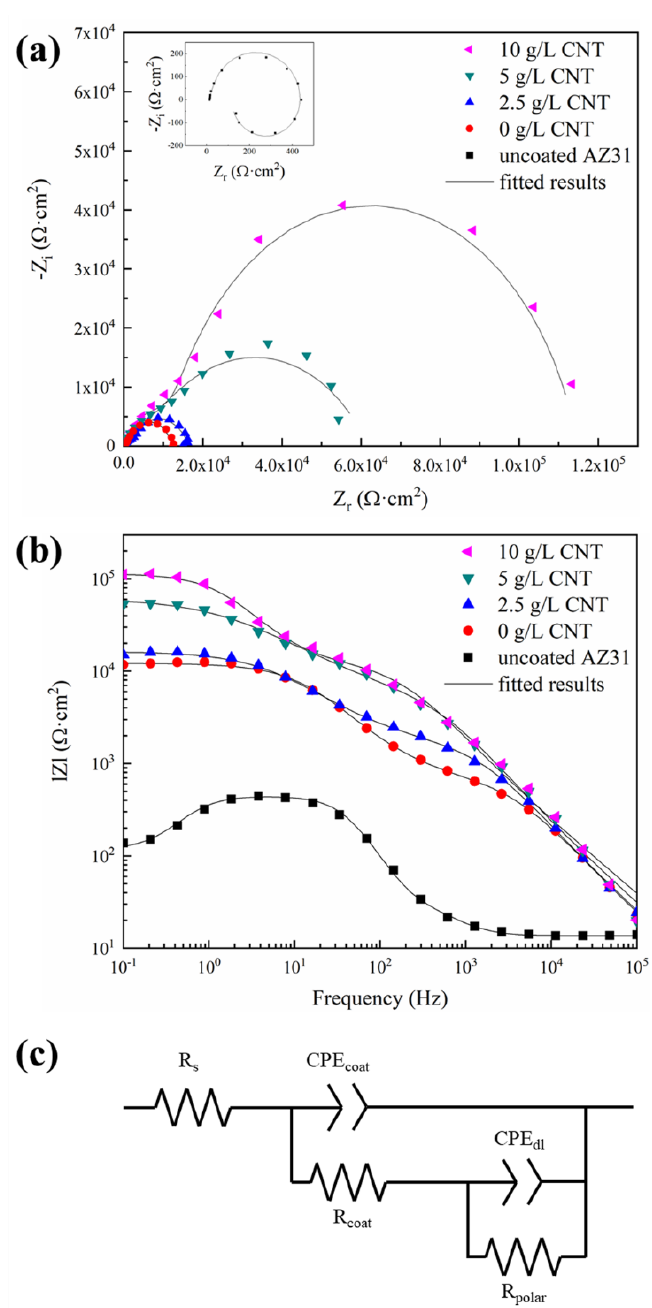
Figure 10. Electrochemical impedance behavior of the PEO coatings in different concentration of CNT: ( a ) Nyquist plot; ( b ) Bode plot; and ( c ) equivalent circuit.